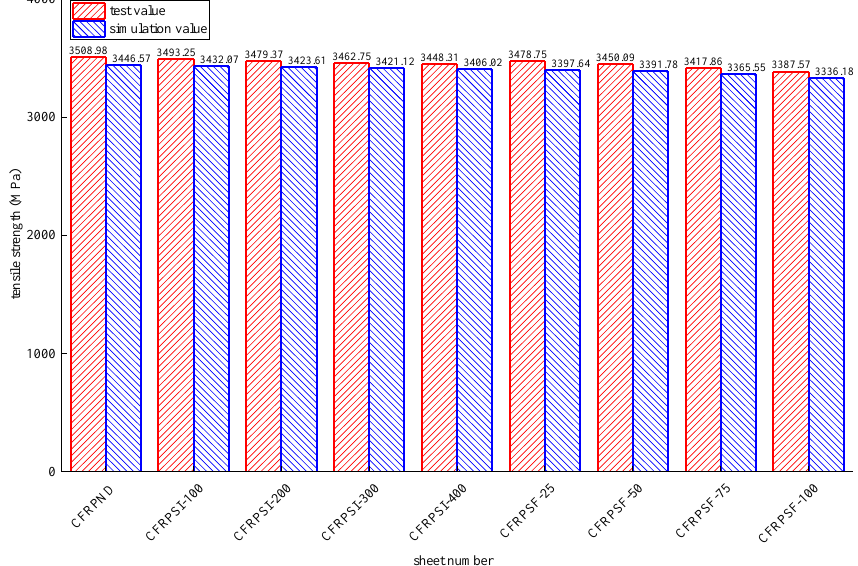
Figure 35. Test values and simulated values of tensile strength of CFRP sheet.